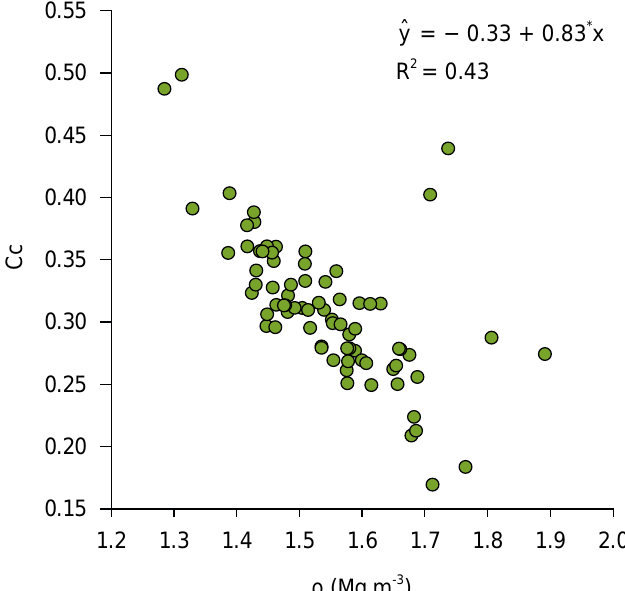
Figure 2. Relationship between soil compaction index ( Cc ) and bulk density (ρ) at layers of 0.00-0.10 and 0.20-0.30 m for soils under irrigated crops and natural vegetation in the Jaguaribe/Apodi Irrigated Perimeter, Limoeiro do Norte, CE, Brazil (n = 76). * : significant